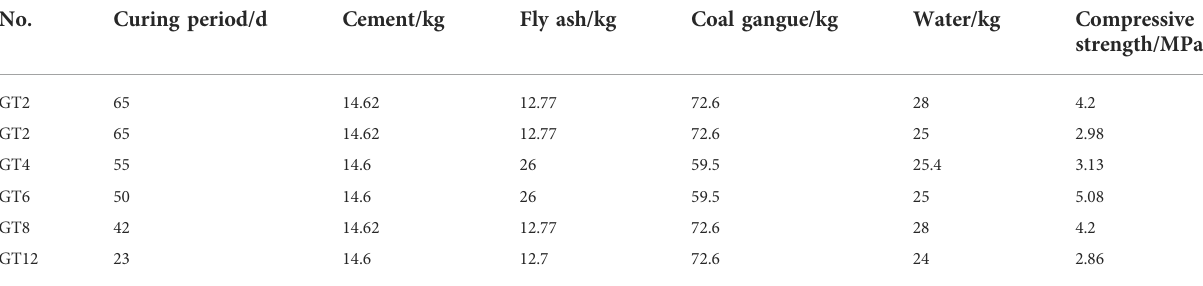
TABLE 4 Uniaxial compression test results for different ratios of the back fi ll body under the ground. No.